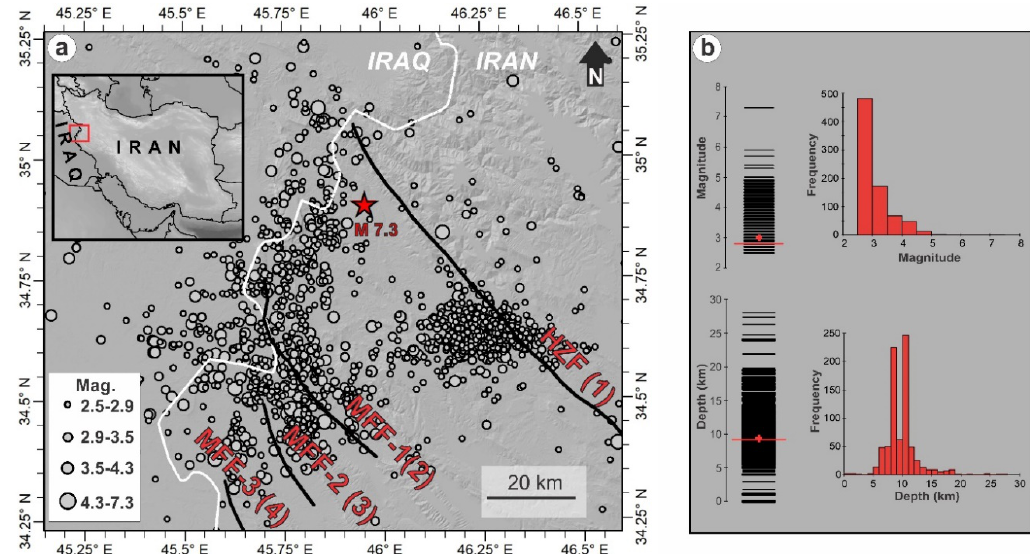
Figure 1. ( a ) Shaded relief of the Shuttle Radar Topography Mission (SRTM) version 4 digital elevation model near the Iran–Iraq border together with aftershocks (gray circles) on different scales. The black lines delineate recognized faults. The dashed white line represents the Iran–Iraq border. The red star shows the location of the main shock (M 7.3) according to the Iranian Seismological Network (ISN). The inset map shows the study area near the Iran–Iraq border. ( b ) Strip plots and histograms of the magnitudes and depths of the aftershocks. The red lines and red plus symbols show the median and mean values, respectively.